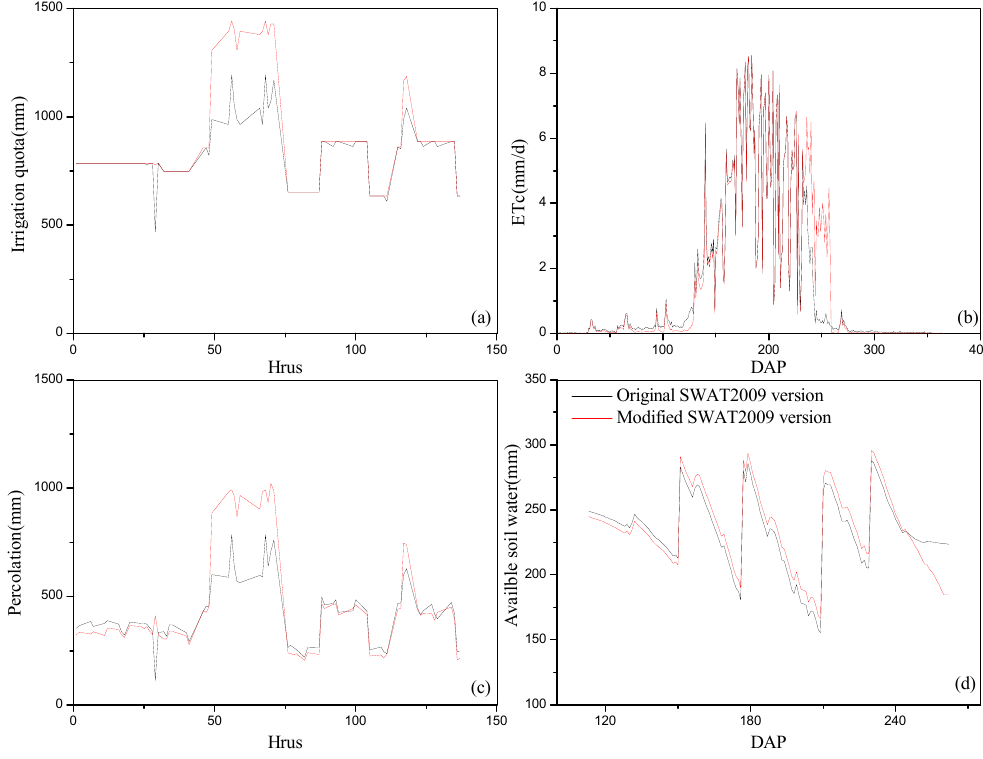
Figure 6. Water balance element of different SWAT versions. (( a ) irrigation quota; ( b ) evapotranspiration; ( c ) perolation; and ( d ) available soil water).